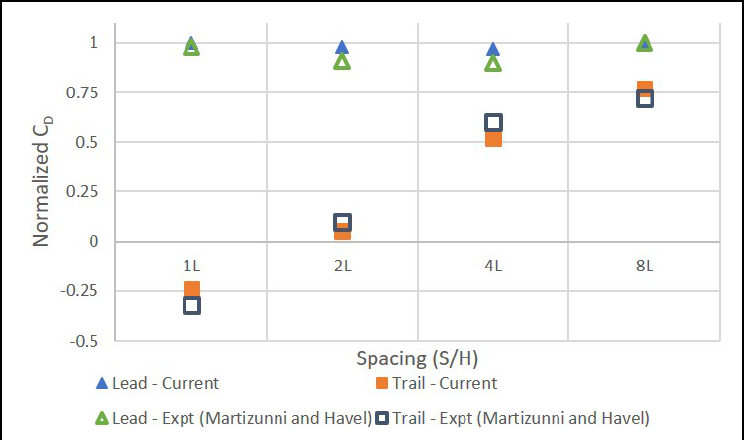
Figure 10. Comparison Drag Coefficients of Lead and Trailing Block Compared to Experimental Results